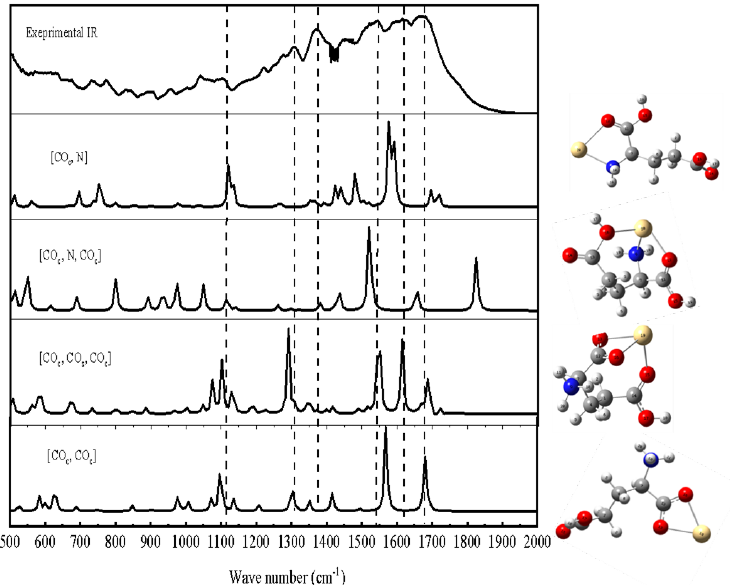
Figure 2. The experimental (upper) and calculated (lower) FTIR spectra of GluCd 2+ . The gray, red, yellow, blue, and silver balls represent carbon, oxygen, cadmium, nitrogen, and hydrogen atoms, respectively.